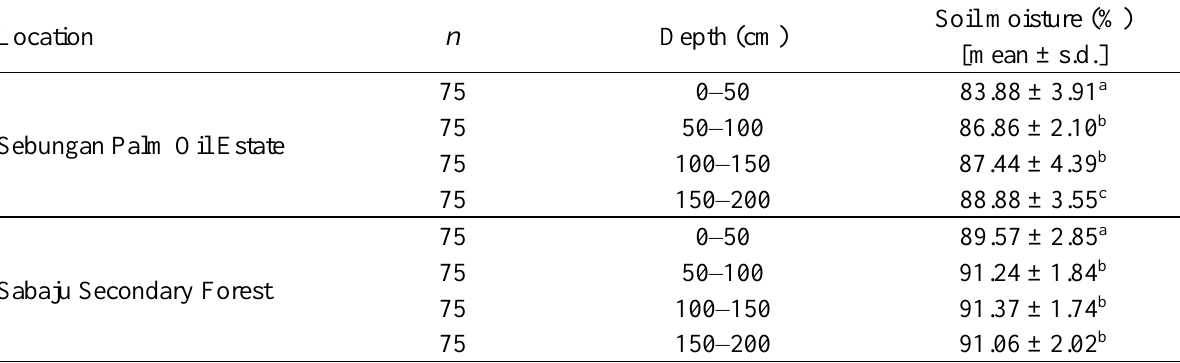
Table 1. Layer-by-layer average soil moisture in Sebungan (oil palm estate) and Sabaju 4 (tropical secondary forest) peat. Depth is measured from the soil surface downwards. There are no significant differences (p > 0.05) between values with the same superscripted letter; s.d. = standard